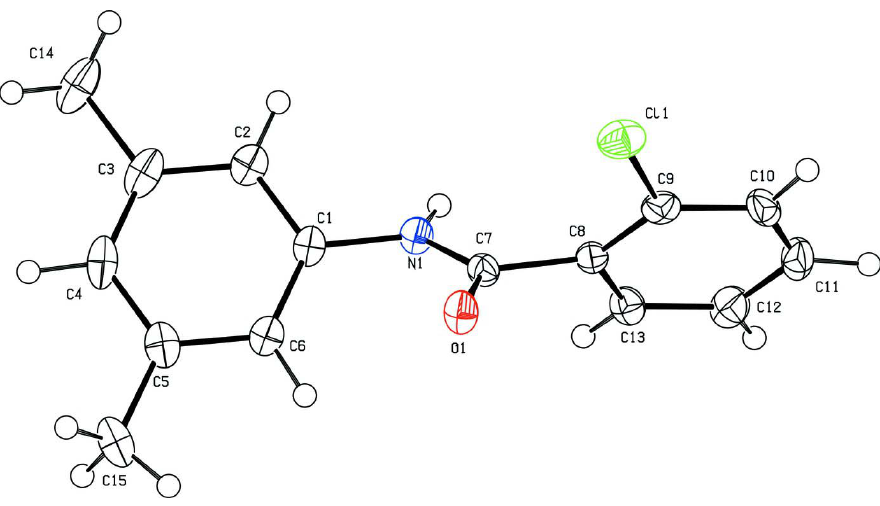
Figure 1 Molecular structure of the title compound, showing the atom labeling scheme. The displacement ellipsoids are drawn at the 50% probability level. H atoms are represented as small spheres of arbitrary